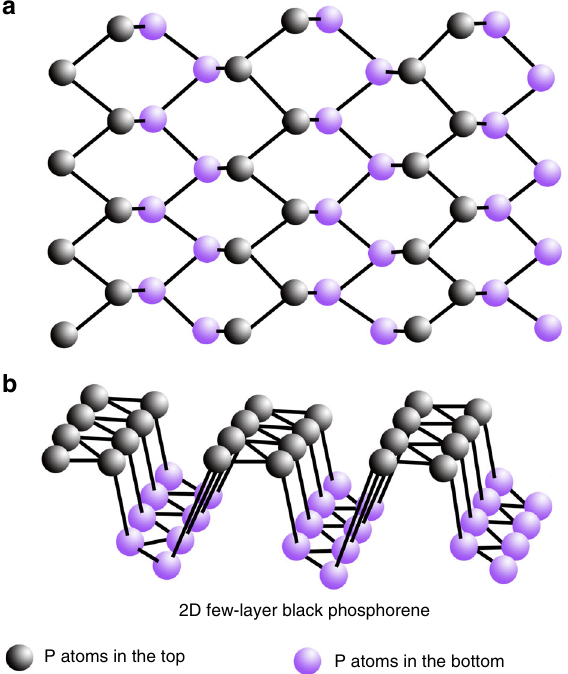
Fig. 1 Schematic illustration of atomic structure of 2D-BP. a Top view. b 3D